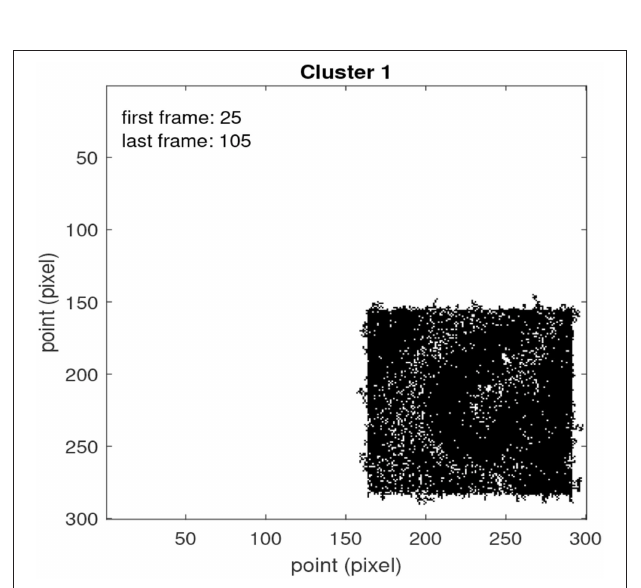
FIGURE 12 | Multi-variate RP computed on the region of interest and time interval reported in Figure 11